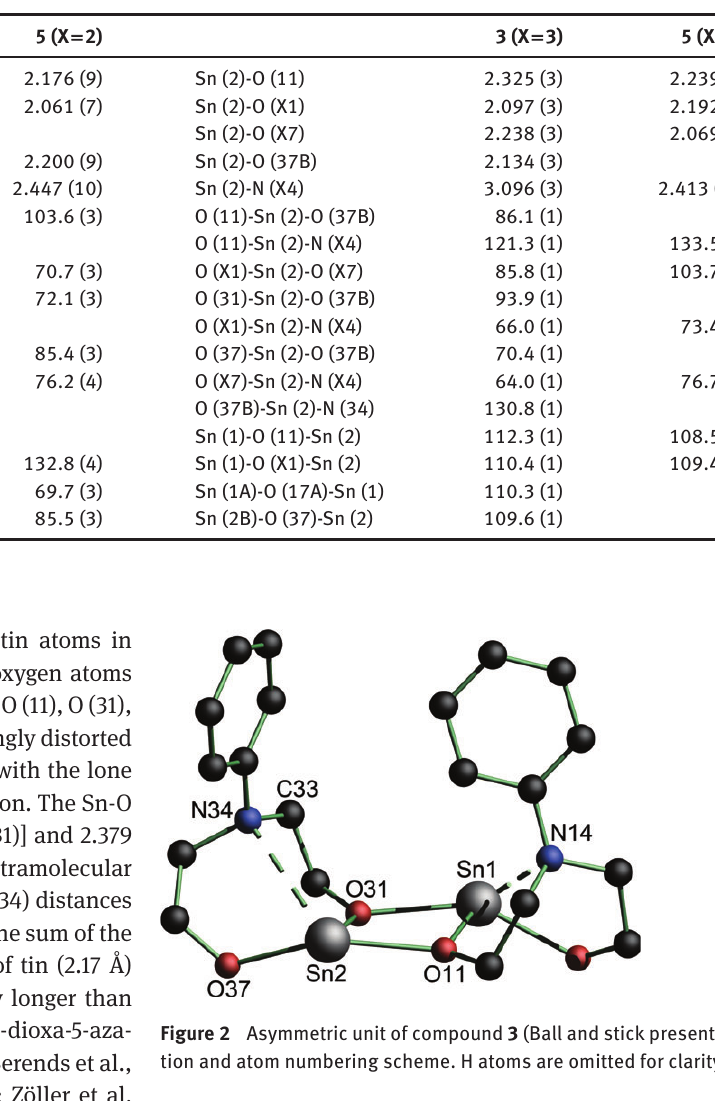
CH O) Sn] ( 5 ) (Berends et al., 2009). 2 2 2 2